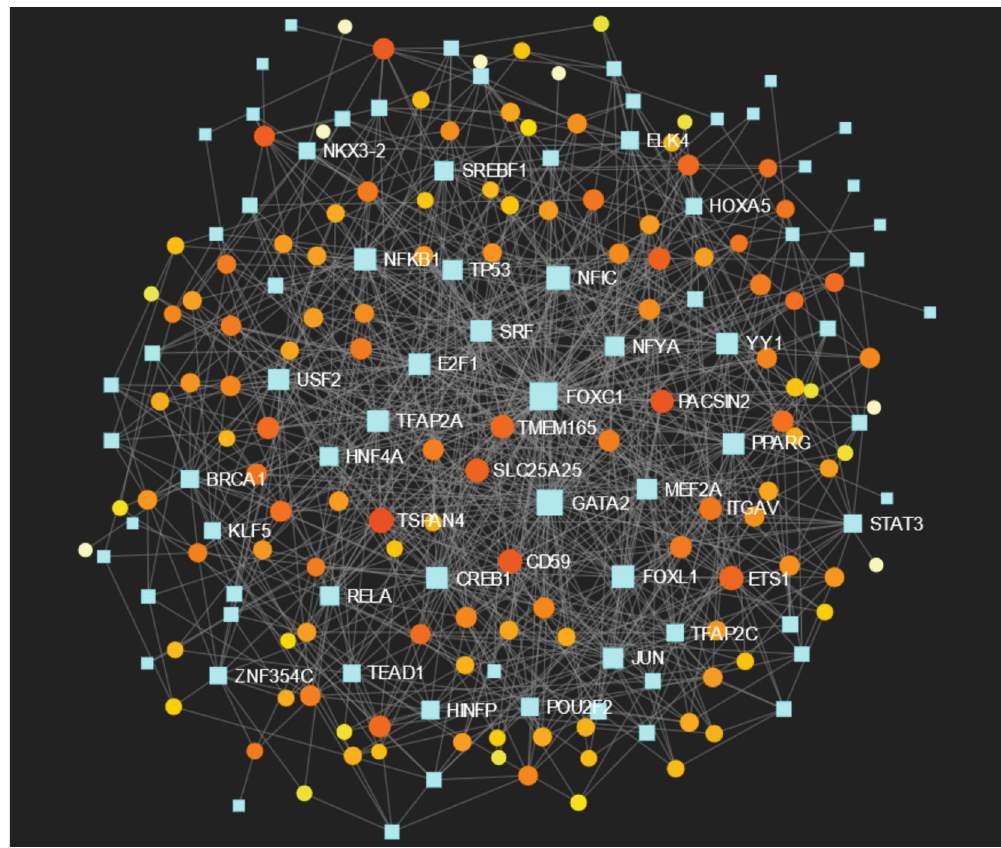
Figure 5: Transcription factor-target DEG regulatory network. Orange and yellow nodes stand for di ff erentially expressed genes; blue diamonds stand for transcription